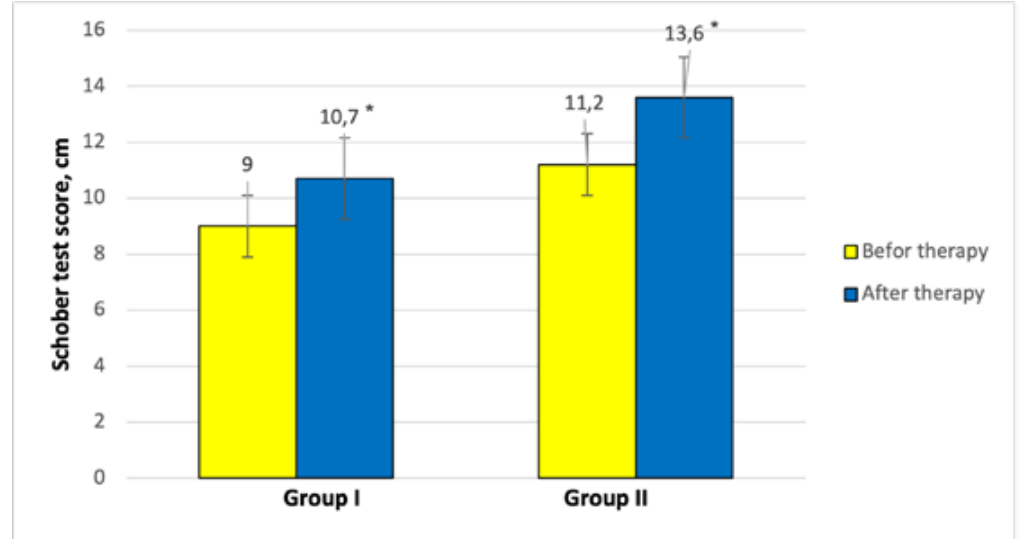
Figure 3. Changes in mean estimates of Schober sample in the direction of bending in groups I (subjects treated with physiotherapy) and in group II (subjects treated with dance and movement therapy) before and after therapy. Statistical significance * p <